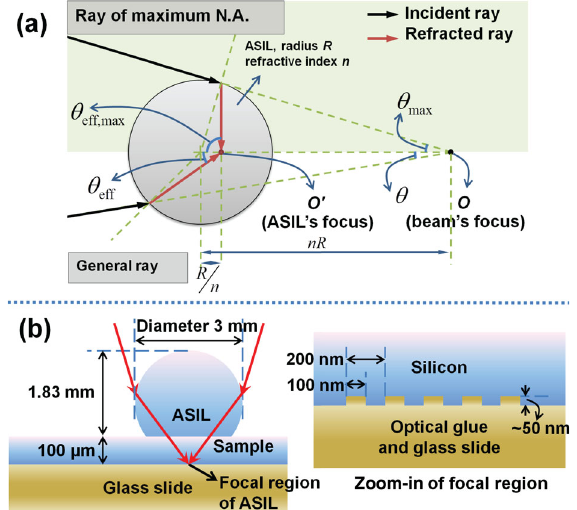
FIG. 6. Focusing through ASIL and geometry of ASIL and sample. The geometric configuration of ASIL, location of its focal point, and refraction at ASIL interface is shown in (a). Geometric details of ASIL used in our experiment and a sample prepared for imaging are shown in